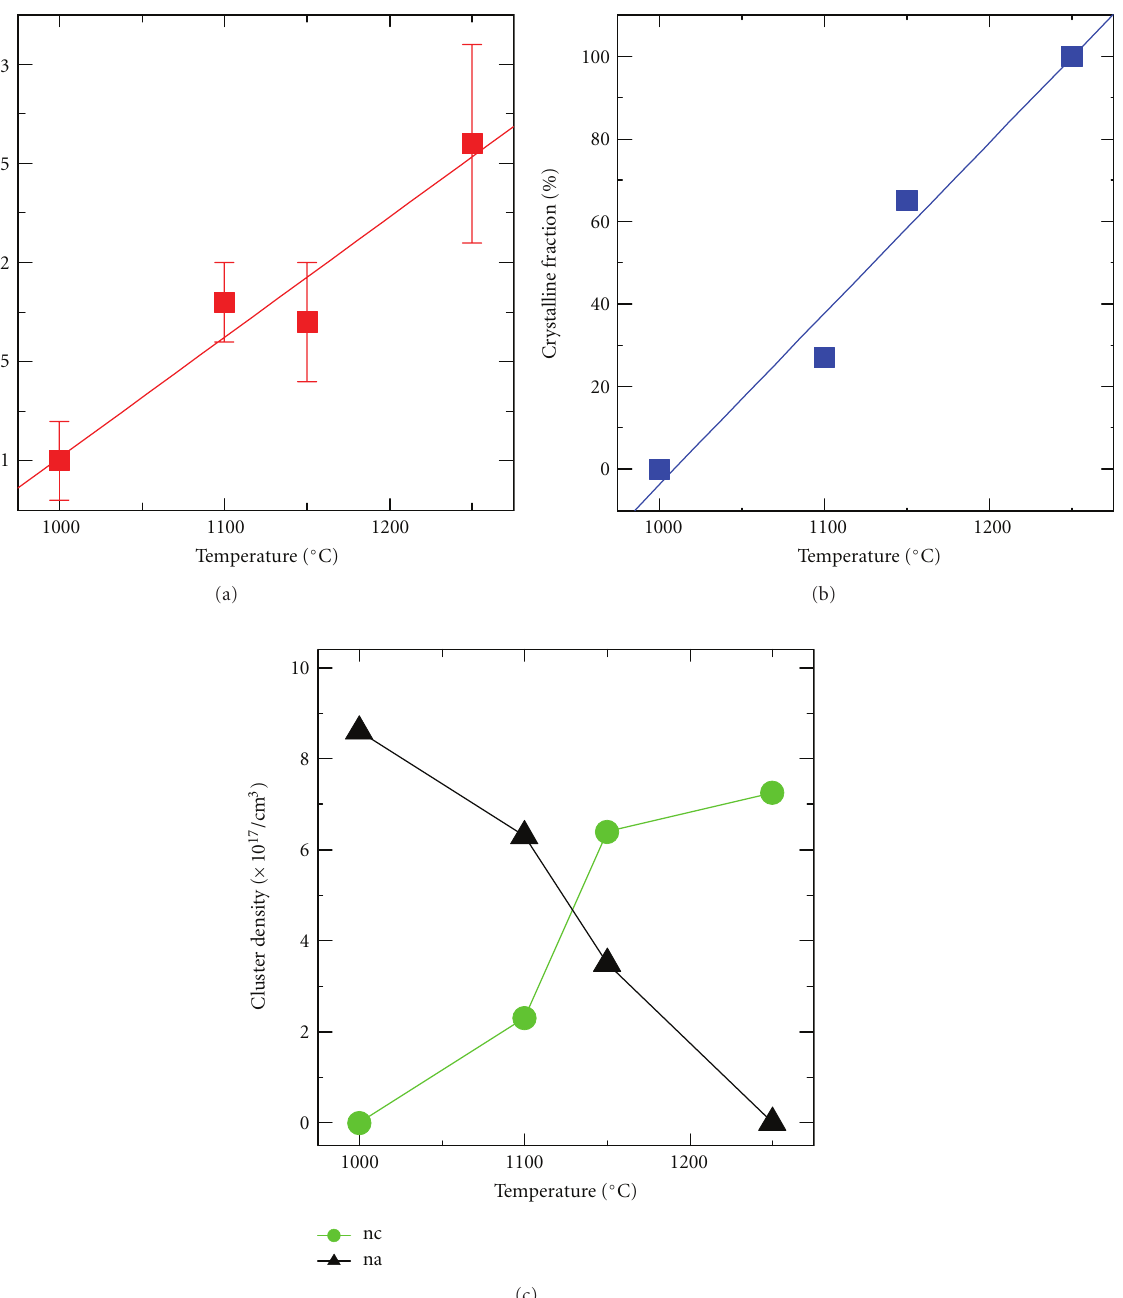
Figure 10: (a) Si nanocluster mean radius obtained from EFTEM images, (b) crystalline fraction obtained from the comparison of EFTEM and DFTEM images, and (c) density of amorphous (na) and crystalline (nc) nanoclusters, as a function of the annealing temperature. The lines are drawn to guide the